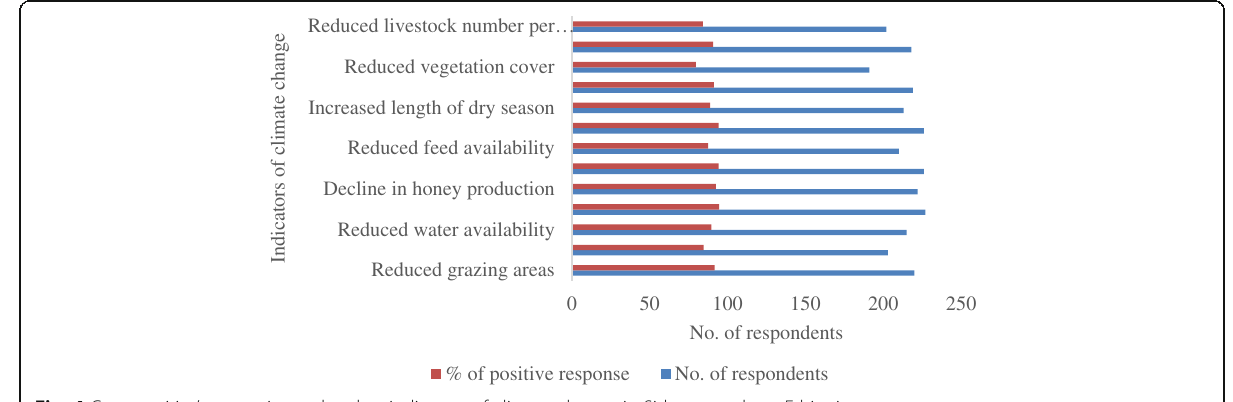
Fig. 4 Communities ’ perceptions related to indicators of climate change in Sidama southern